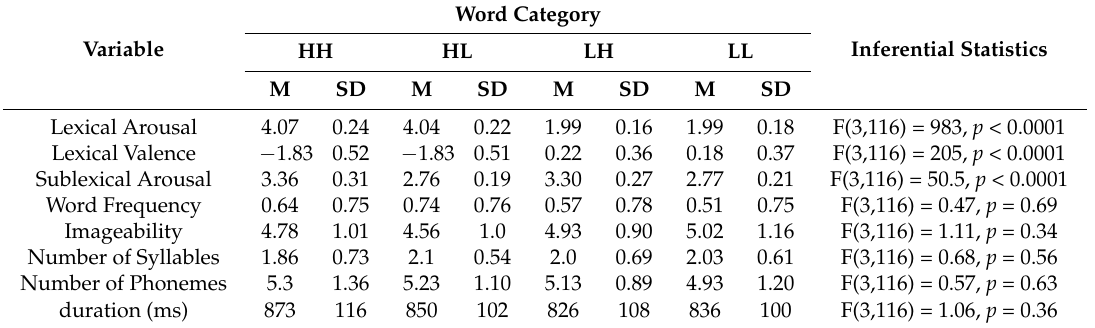
Table 1. Characteristics of word